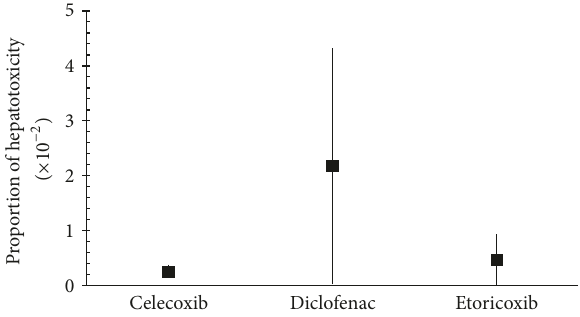
Figure 2: Proportion of hepatotoxicity induced by